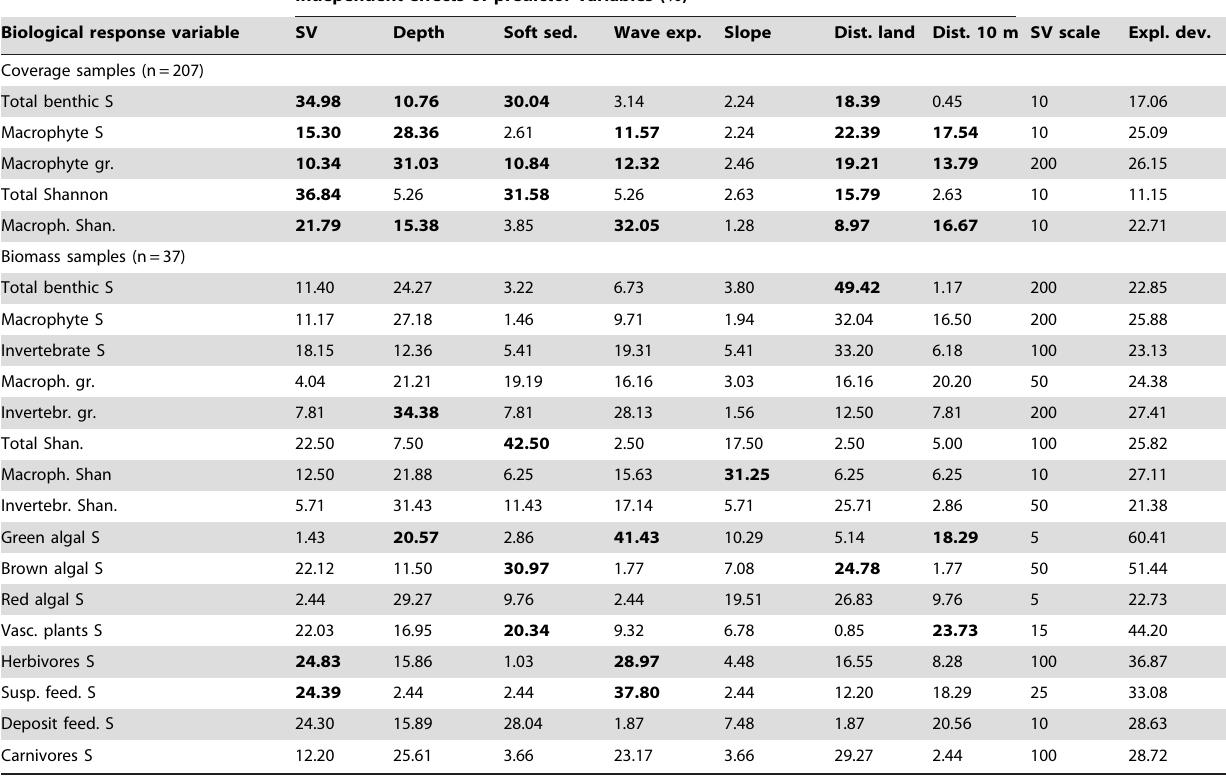
Table 7. Results of generalized linear